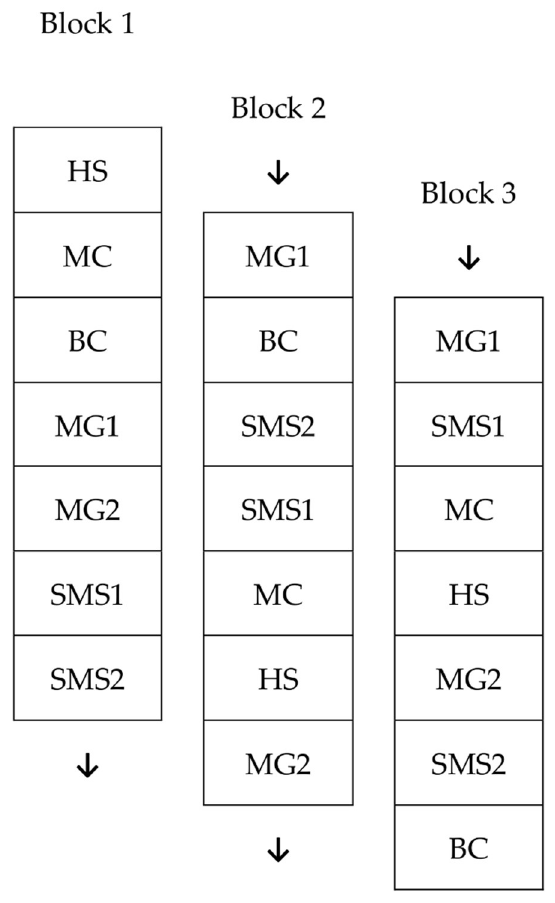
Figure 2. Diagram of the experimental layout used in the presented study, where each rectangle represents experimental plots as follows: HS—herbicide strip; MC—mechanical cultivation; BC— synthetic mulch; MG1— Miscanthus × giganteus mulch I; MG2— Miscanthus × giganteus mulch II, SMS1—spent mushroom substrate mulch I; SMS2—spent mushroom substrate mulch